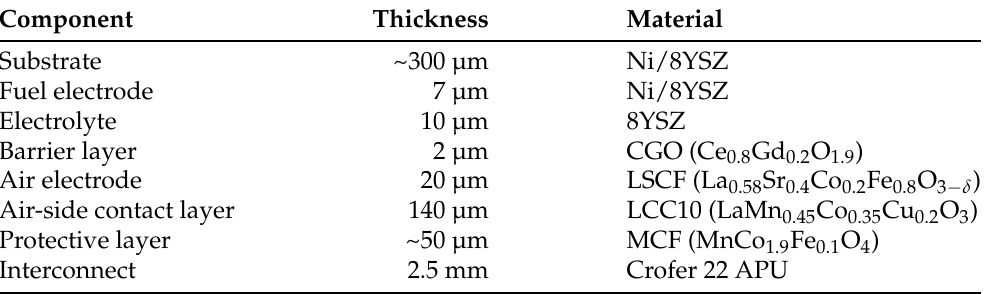
Table 1. Cell and stack components of a repeating